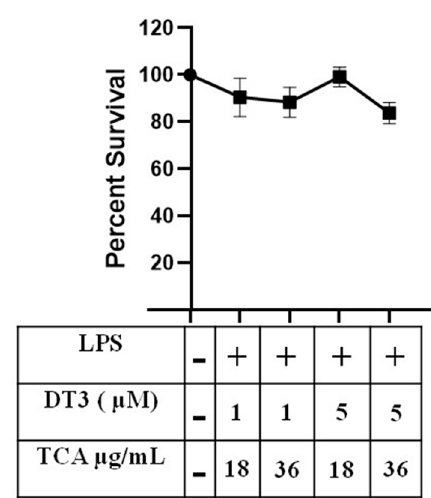
Figure 2. Delta-tocotrienol and tart cherry anthocyanin (TCA) in combination are not toxic to cells. DT3 1 µ M + TCA 18 µ g / mL DT3 1 µ M + TCA 36 µ g / mL, DT3 5 µ M + TCA 18 µ g / mL, DT3 5 µ M + TCA 36 µ g / mL DT3 and TCA were added to 3T3-L1 adipocytes to check viability. n = 2, * p < 0.05 .